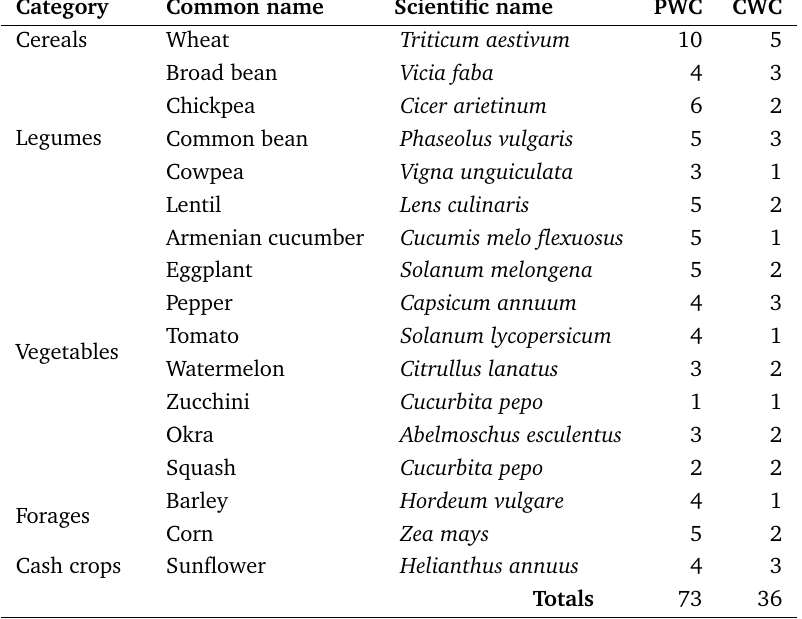
Figure 1. Study area. The inset map shows the research area in green, relative to the whole of Syria. Source: Humanitarian Data Exchange https://data.humdata.org/dataset/syrian-arab-republic-administrative-boundaries-populated-places Table 1. Status of the cultivation of landraces by crop category across the study area (NW Syria) in 2019. PWC, previously widely cultivated, i.e. common and widely available in the communities in terms of yield and seed during the period 1999–2019; CWC, currently widely cultivated, i.e. previously widely cultivated, and still common and widely